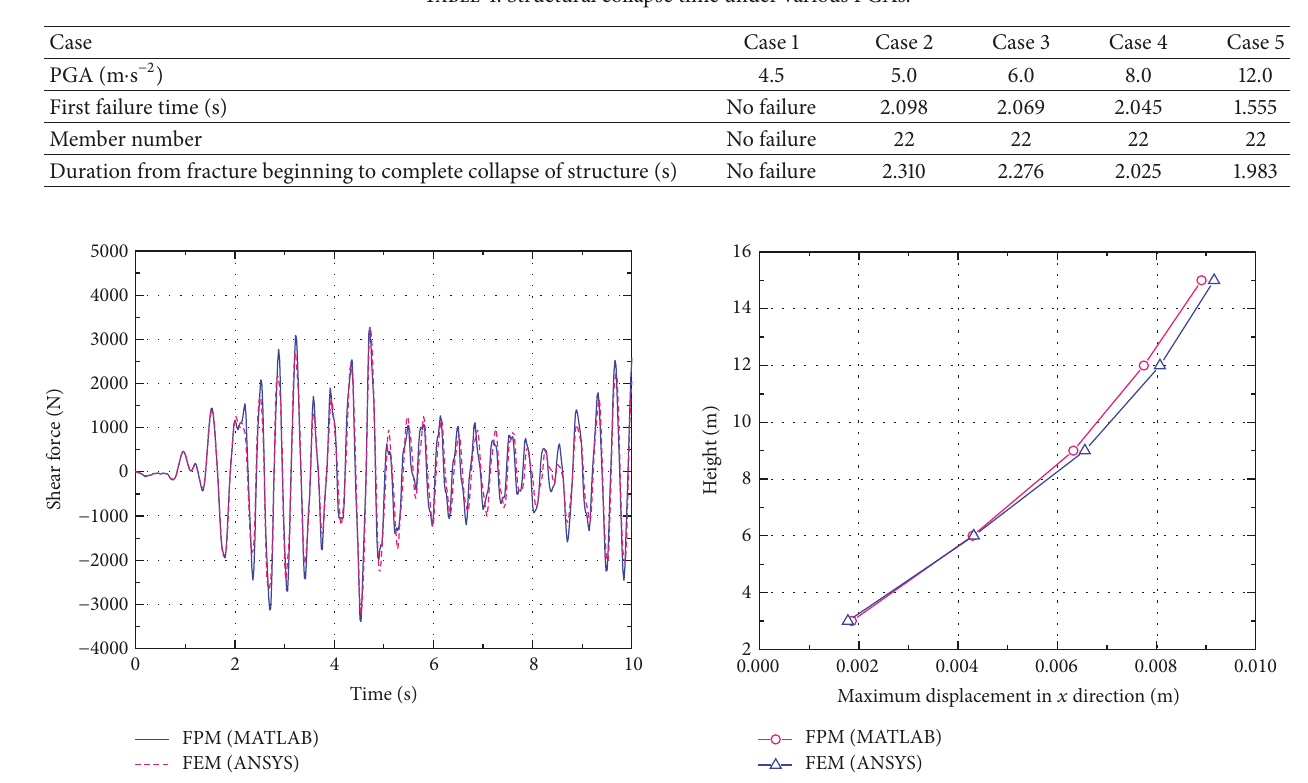
Table 4: Structural collapse time under various PGAs.